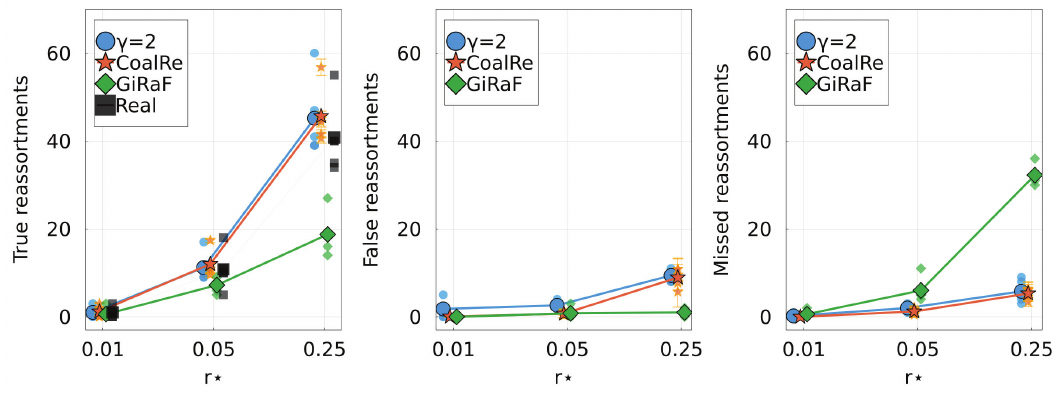
Fig 5. Comparison of TreeKnit with CoalRe [9, 17] and GiRaF [14, 21] on simulated ARGs of 100 leaves. For three reassortment rates, shows the Left : number of true reassortments, Center : number of false reassortments, and Right : number of missed reassortments, for all three methods. Large markers represent the average over 5 simulations for each r ? . Smaller markers show results on individual ARGs. Results for each method are slightly shifted on the r ? -axis for visibility.